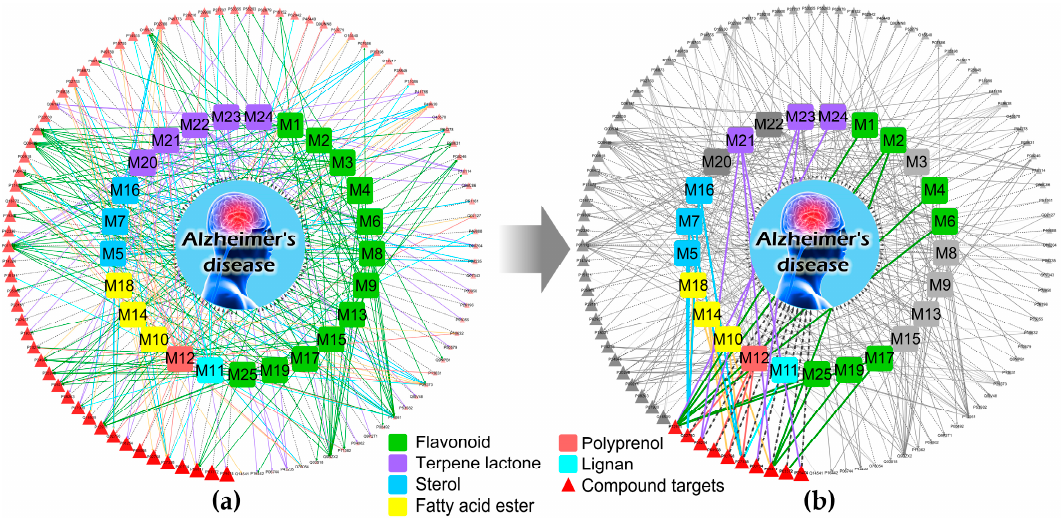
Figure 6. Illustration of the Compound-Target-Disease network. Rounded squares in different colors represent different groups of compounds; the code is shown on each rounded square. Red triangles represent putative target proteins, and triangles shown in darker colors and larger sizes represent greater associations with AD. All candidate compounds and putative target proteins are shown in panel ( a ). The top 10 putative target proteins and the candidate compounds directly related to them are highlighted based on the relevance score; other target proteins are grayed out in panel ( b ).